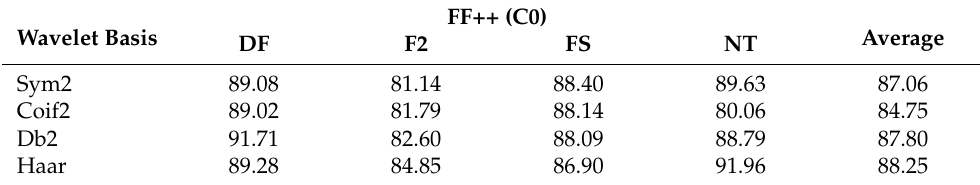
Table 5. The ACC results of different wavelet bases under the high compression scene (C40). Wavelet Basis